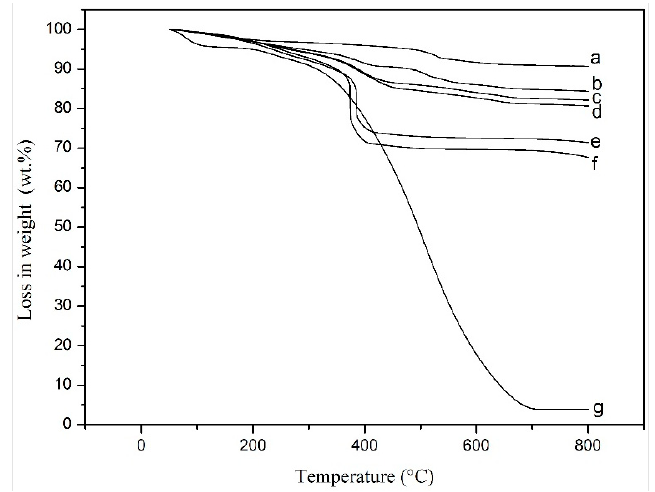
Figure 6. TGA curves of pure MnO 2 (a), PANI/MnO 2 composites (b: C1; c: C2; d: C3; e: C4; f: C5), and pure PANI (g). Table 2. PANI content and MnO 2 content in the prepared PANI/MnO 2 composite.